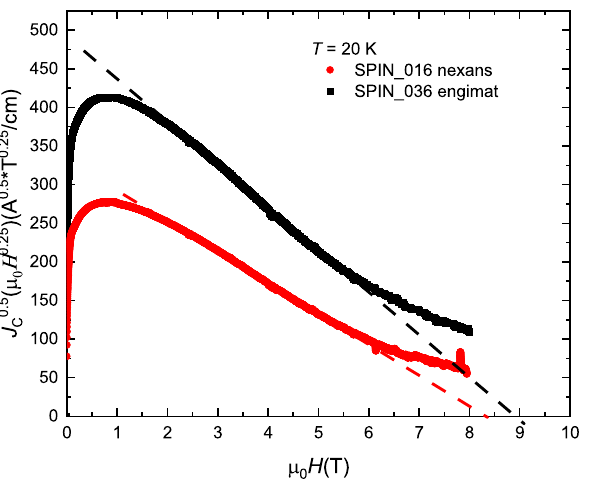
Figure 7. Fit of the linear part of the Kramer plot where is defined the H K as the intercept of the applied field